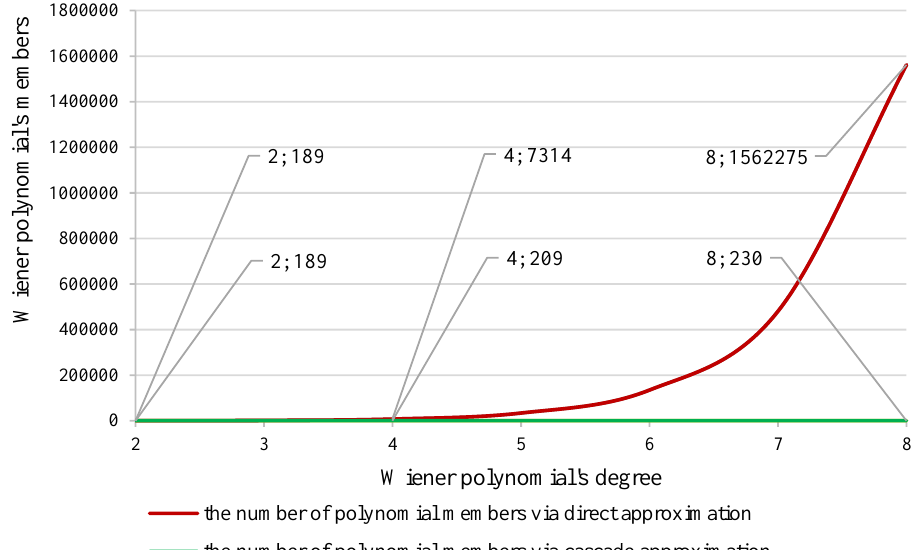
Figure 8. The number of the Wiener polynomial members during approximation of the stated dataset by different polynomial degrees (2–8) via direct and proposed cascade approximations. The first number in the chart indicates the polynomial degree, and the second number indicates the member’s number.